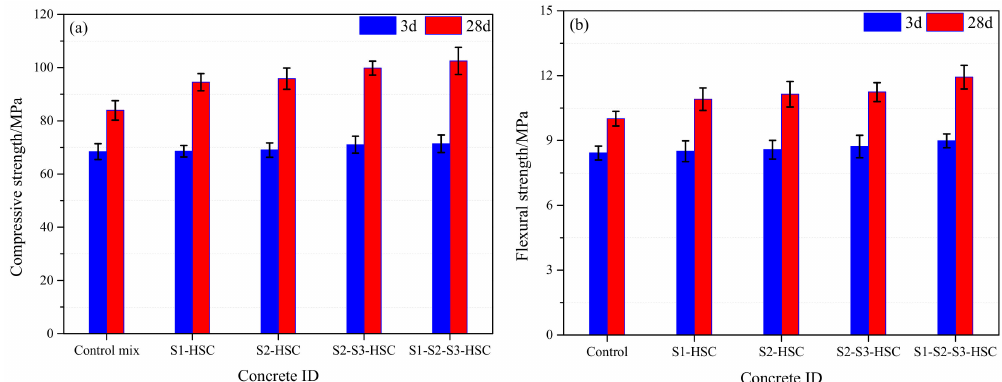
Figure 5. Mechanical properties of concrete at the AT: ( a ) compressive and ( b ) flexural strength.